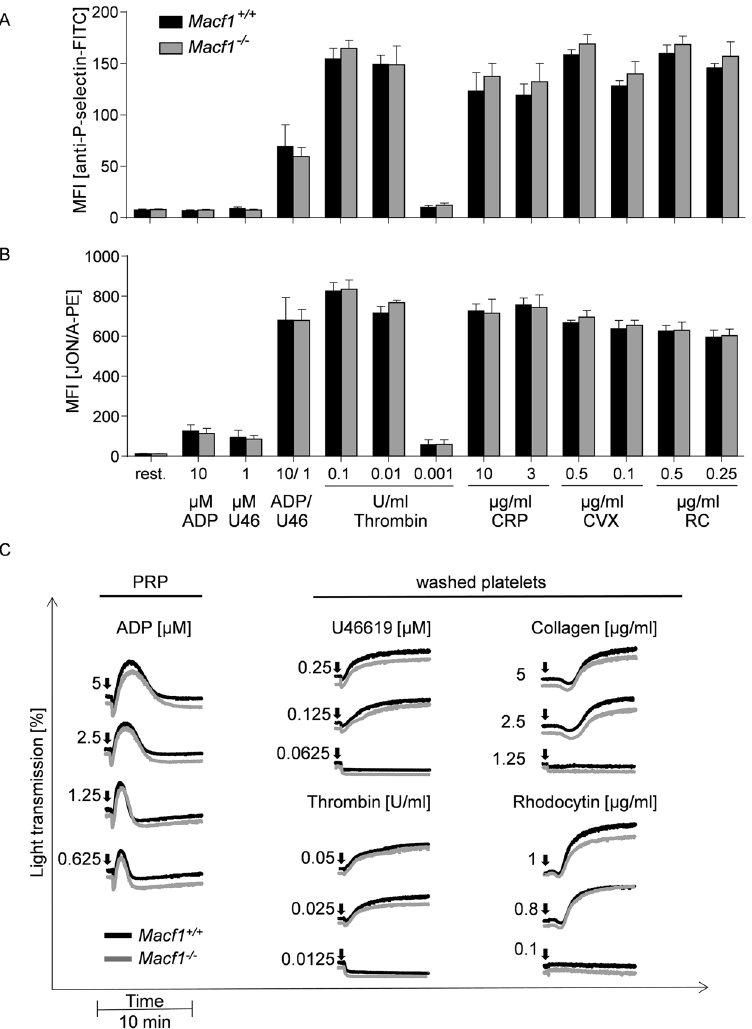
Figure 2. Unaltered P-selectin exposure, α IIb β 3 integrin activation and aggregation responses to GPCR, GPVI and CLEC-2-dependent agonists of Macf1 − / − platelets. (A) Degranulation dependent P-selectin exposure using a FITC-labelled anti-P-selectin antibody and (B) inside-out activation of α IIb β 3 integrin using the JON/A-PE antibody (n = 6, representative for four independent experiments) in response to agonists ADP, U46619 (thromboxane analogue), Thrombin, collagen-related peptide (CRP), convulxin (CVX) and Rhodocytin (RC) were determined by flow cytrometry. (C) Aggregation studies: Platelet rich plasma (PRP) or washed platelets from Macf1 + / + and Macf1 − / − mice were activated with the indicated agonist concentrations (n =